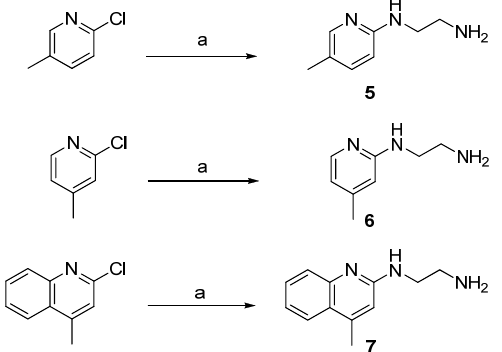
Scheme 2. Synthesis of substituted aminopyridines and